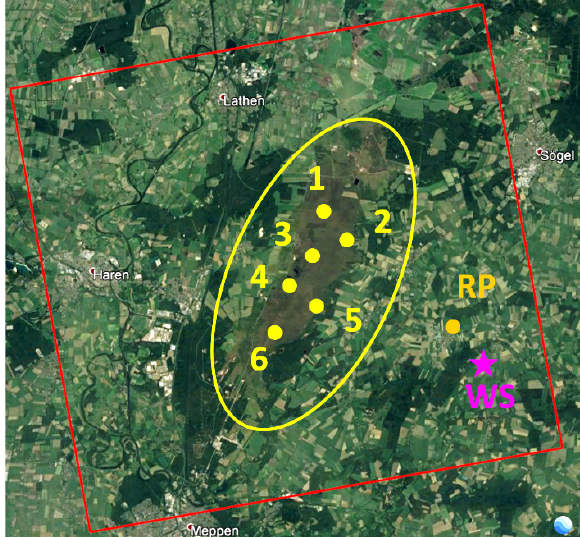
Figure 3. Test moor area (yellow circle) in nature reserve – Tinner Dose-Sprakeler Heide, Germany. Target points 1 – 6 used for in-depth analysis. RP, Reference Point used in SBAS. WS, Weather Station (Groß Berßen) operated by DWD. Red rectangle, coverage of Sentinel-1 images (20 km × 20 km). Background downloaded from Google Earth.